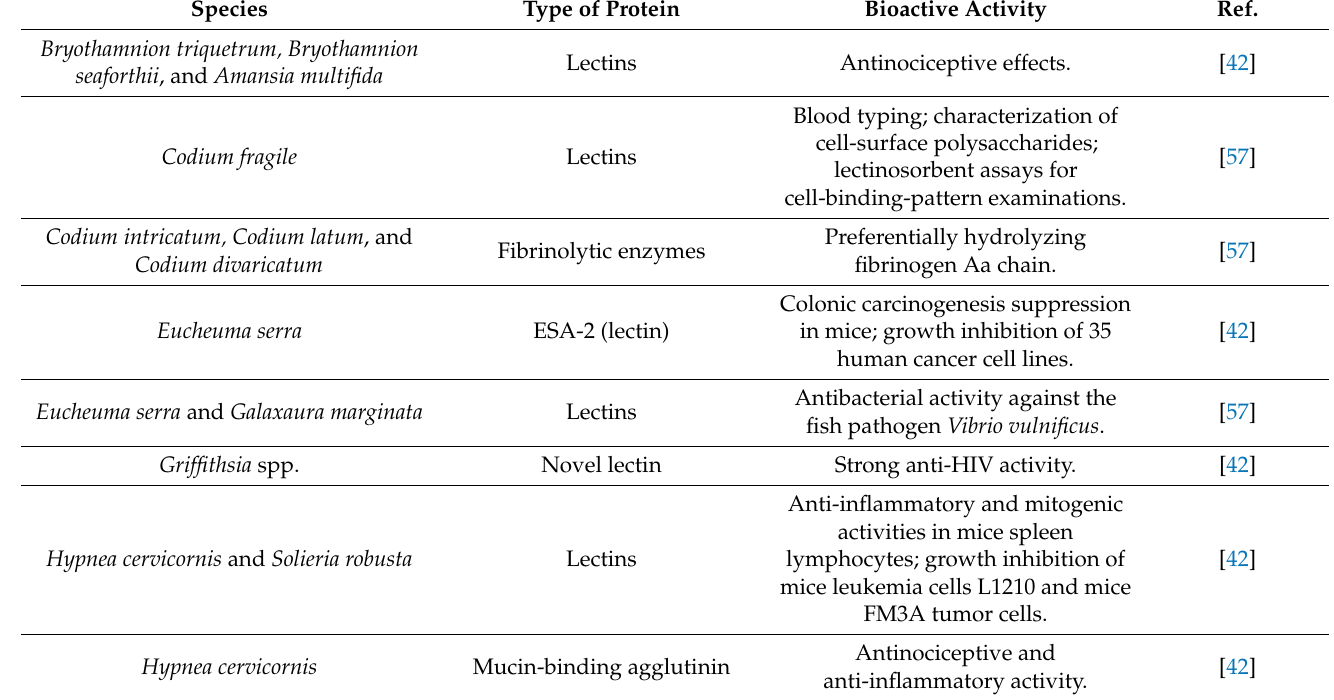
Table 1. The bioactivities of several macroalgal